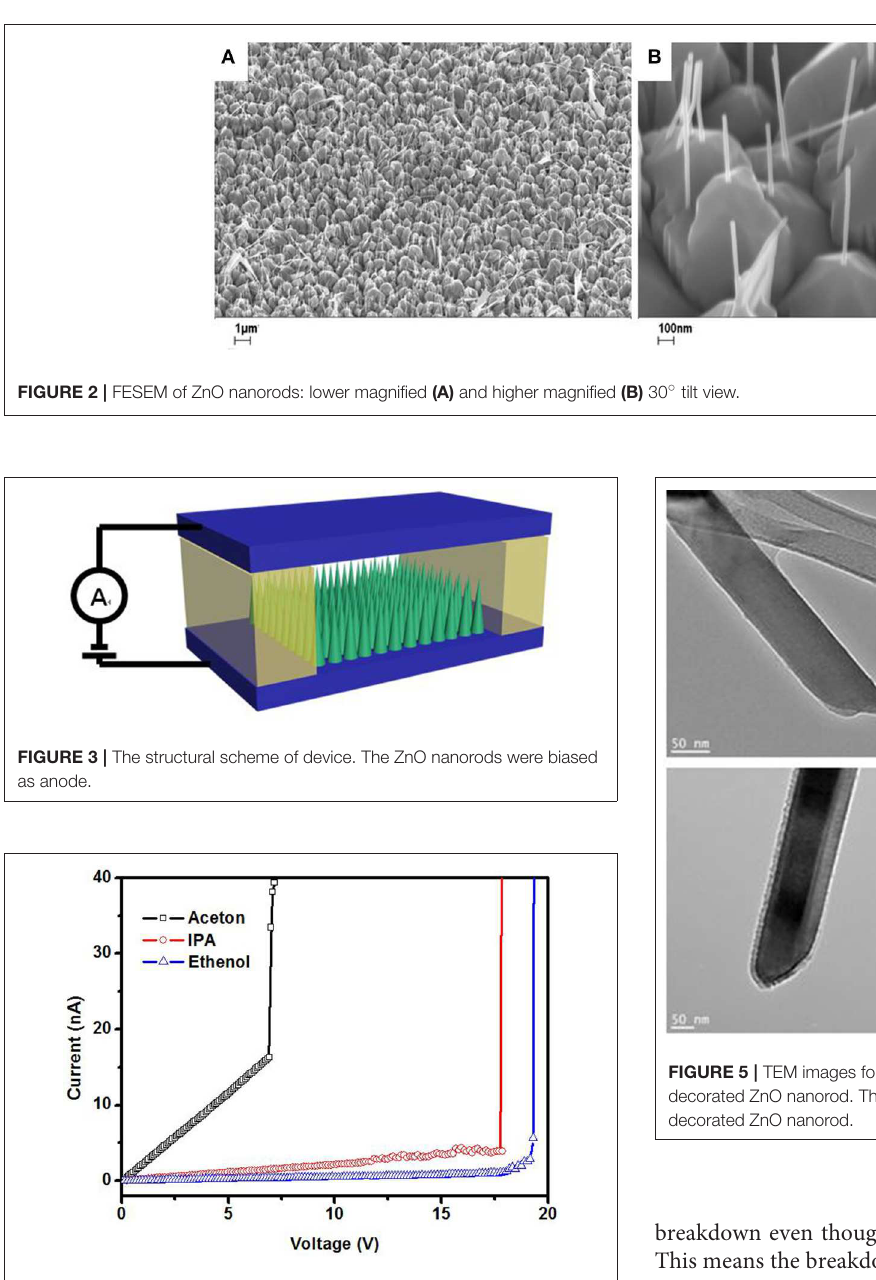
FIGURE 4 | The volt–ampere curves at different atmosphere.